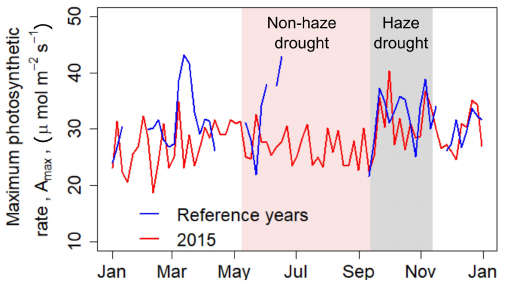
Figure 4. The 5d running mean of maximum rate of photosynthe- sis (A max ) during 2015 and during the reference time period. Sign convention has been performed to avoid negative values of A max . Shaded areas in red and grey mark the non-haze drought and the haze drought period in 2015, respectively.